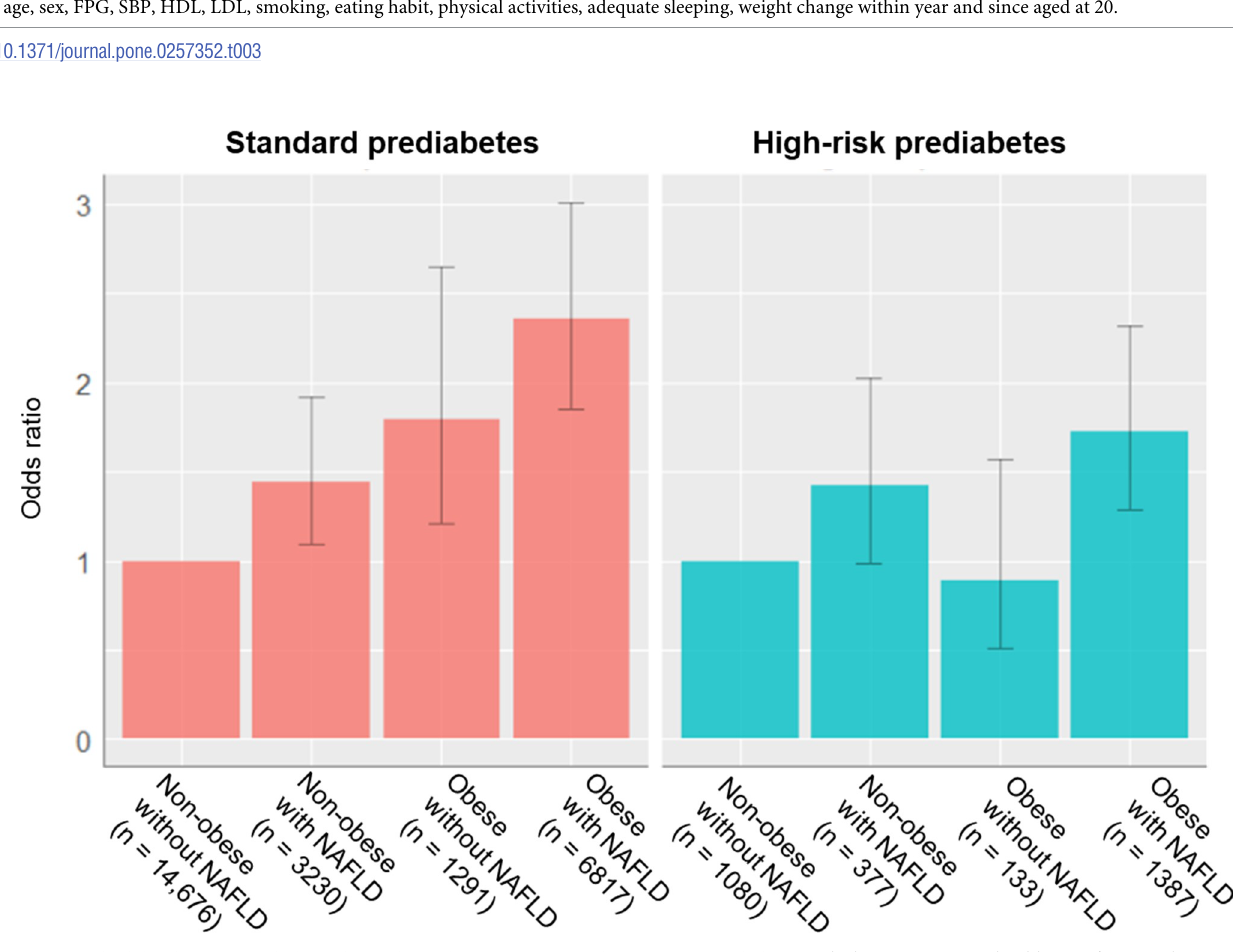
Fig 3. Risk of developing new diabetes for each combination pattern of FLI-NAFLD and obesity. The bars represent each odds ratio for non-obese patients without FLI-NAFLD, and error bars represent 95% CI of the odds ratio.